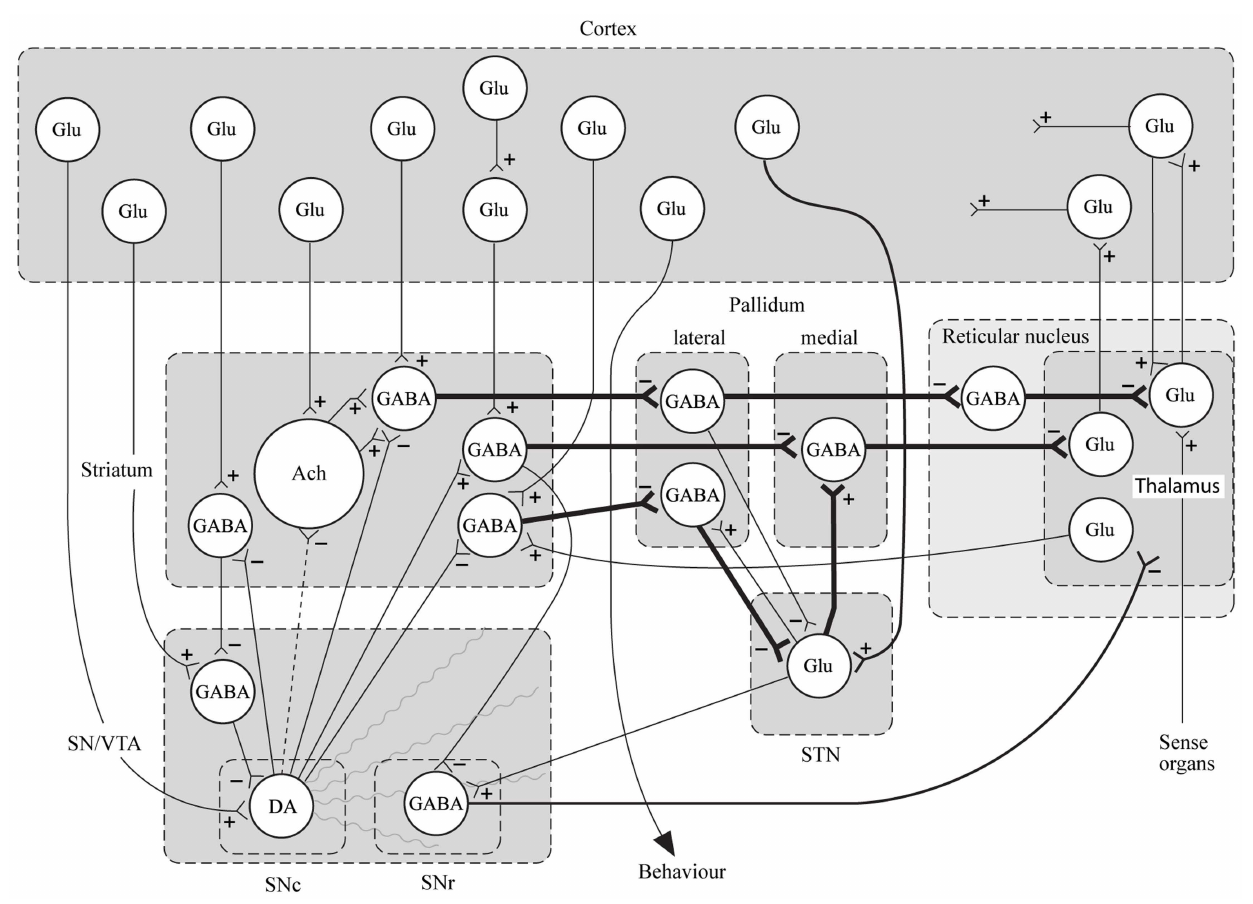
FIGURE 7 | Specific neurocircuitries of the basal ganglia. In this figure the striato-pallido-thalamic pathways are detailed. Among these, the top and bottom pathways drawn with thick lines contain three gabaergic neurons and are referred to as “indirect” pathways.The pathway in between contains two